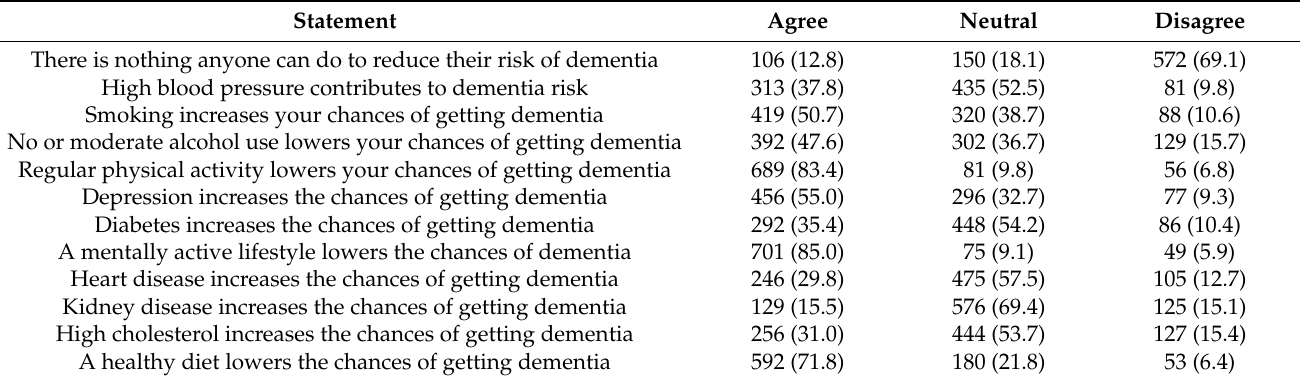
Table 2. The proportion of participant responses to the dementia awareness